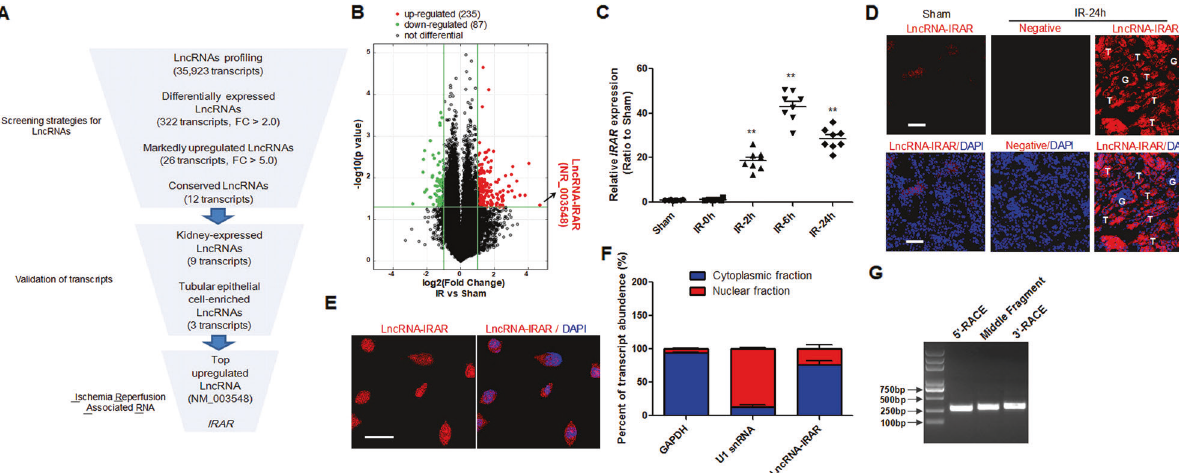
Fig. 1 IRAR is induced by ischemia reperfusion (IR) in mice. A Screening strategy of IR-induced murine lncRNAs derived from microarray pro fi ling. B A volcano plot showed the differentially expressed lncRNAs in IR group compared to Sham group. Red and green dots represent upregulated and downregulated lncRNAs in kidneys 24 h after IR, respectively (fold-change ≥ 2.0 and p -value ≤ 0.05). Black dots represent the genes that were not differentially expressed. IRAR is highlighted in red. C Time course of IRAR expression. Data represent mean ± SEM. n = 6-8, ** p < 0.01 versus Sham group. D RNA fl uorescence in situ hybridization (FISH) assay of IRAR in the mouse kidney samples at 24 h after IR. Scale bar, 100 μ m. E FISH assay of IRAR in the hypoxia-treated mTECs. Scale bar, 25 μ m. F The expression level of IRAR in cytoplasm and nuclei of hypoxia-treated mTECs. GAPDH (cytoplasm retained) and U1 (nuclear retained) were used as controls. G 3 ′ and 5 ′ rapid ampli fi cation of cDNA ends (RACE). Agarose gel electrophoresis of PCR products from the 5 ′ -RACE and 3 ′ -RACE